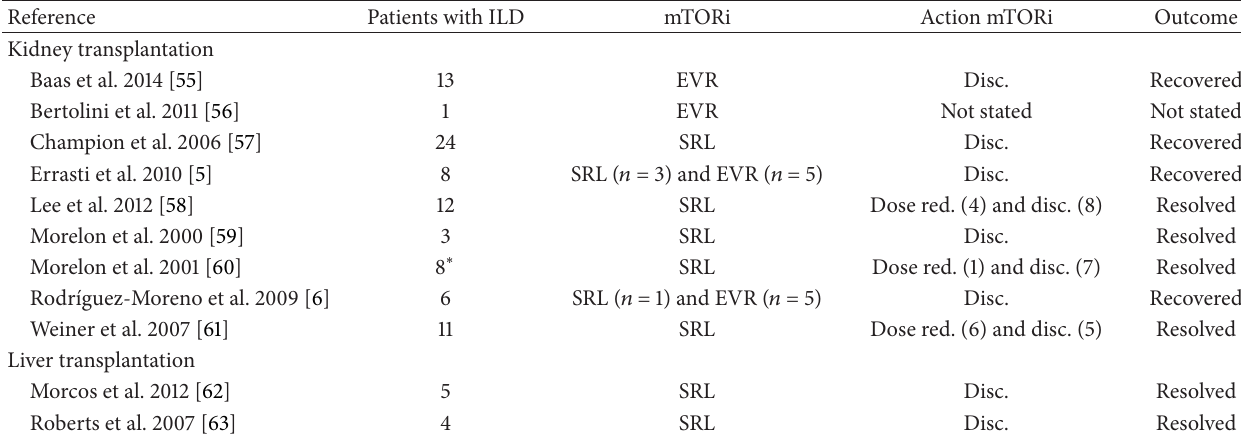
Table 3: Summary of publications with limited case-by-case